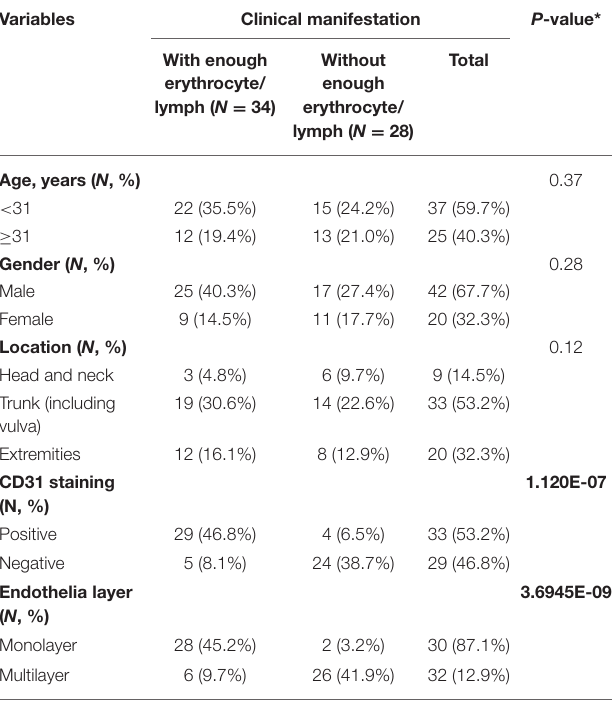
TABLE 2 | Associations between the clinical manifestation and clinicopathologic characteristics of lymphangioma cases.